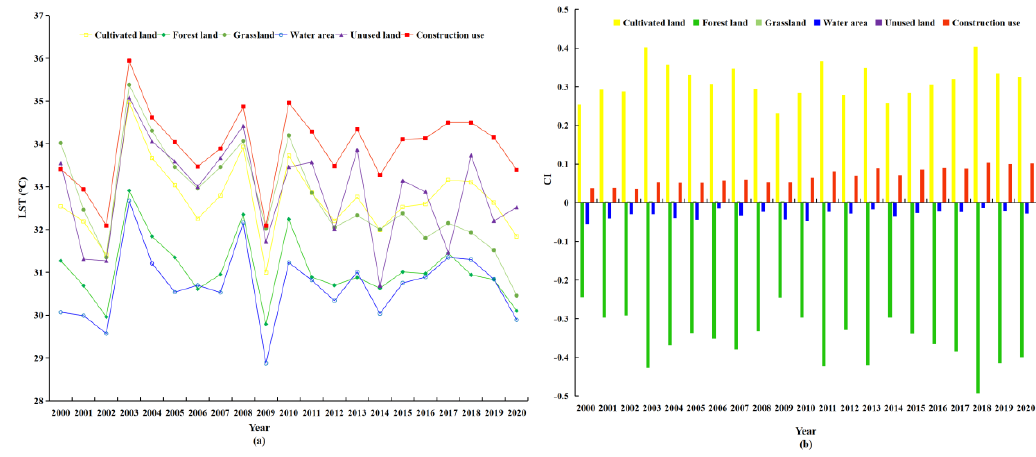
Figure 7. ( a ) LST mean and ( b ) CI of each land use type from 2000 to 2020.